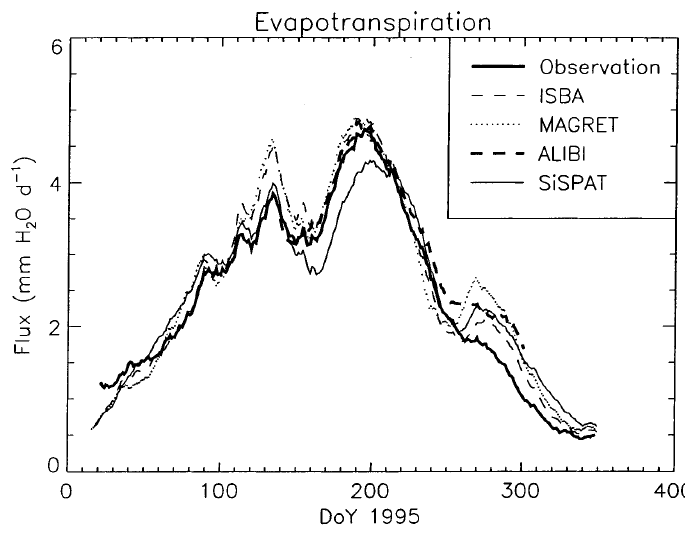
Fig. 10. The daily evapotranspiration as measured and modelled by ISBA, MAGRET, and ALiBi over 1995. The annual cycle is smoothed using a 30-day moving average in order to show the